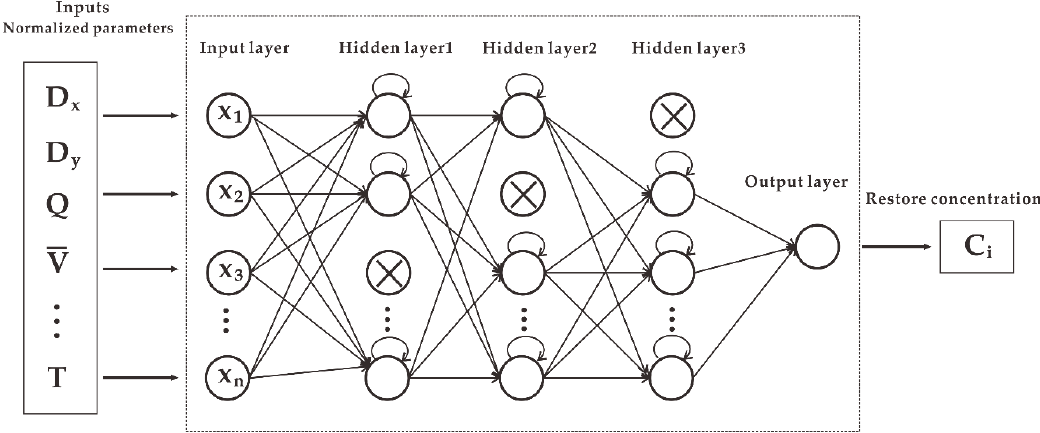
Figure 7. The structure of the LSTM model with dropout for toxic gas diffusion prediction.